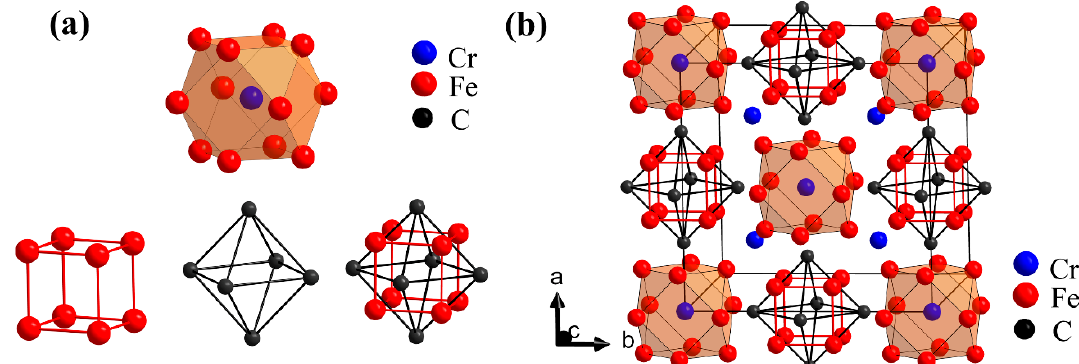
Figure 3. (Color online) ( a ) Cr4a-Fe48h polyhedron and Fe32f-C24e cuboctahedron in Fe 20 Cr 3 C 6 . The Cr4a-Fe48h polyhedron is composed of a centrally located Cr4a atom and 12 nearest neighbor Fe48h atoms. The Fe32f-C24e cuboctahedron comprises a Fe32f cube and C24e regular octahedron nested through a shared center; ( b ) Simplified structure of Fe 20 Cr 3 C 6 . The structure cell consists of polyhedrons and cuboctahedrons. The arrangement of the basic structures is similar to NaCl, and Cr8c is positioned at the interstitial site.